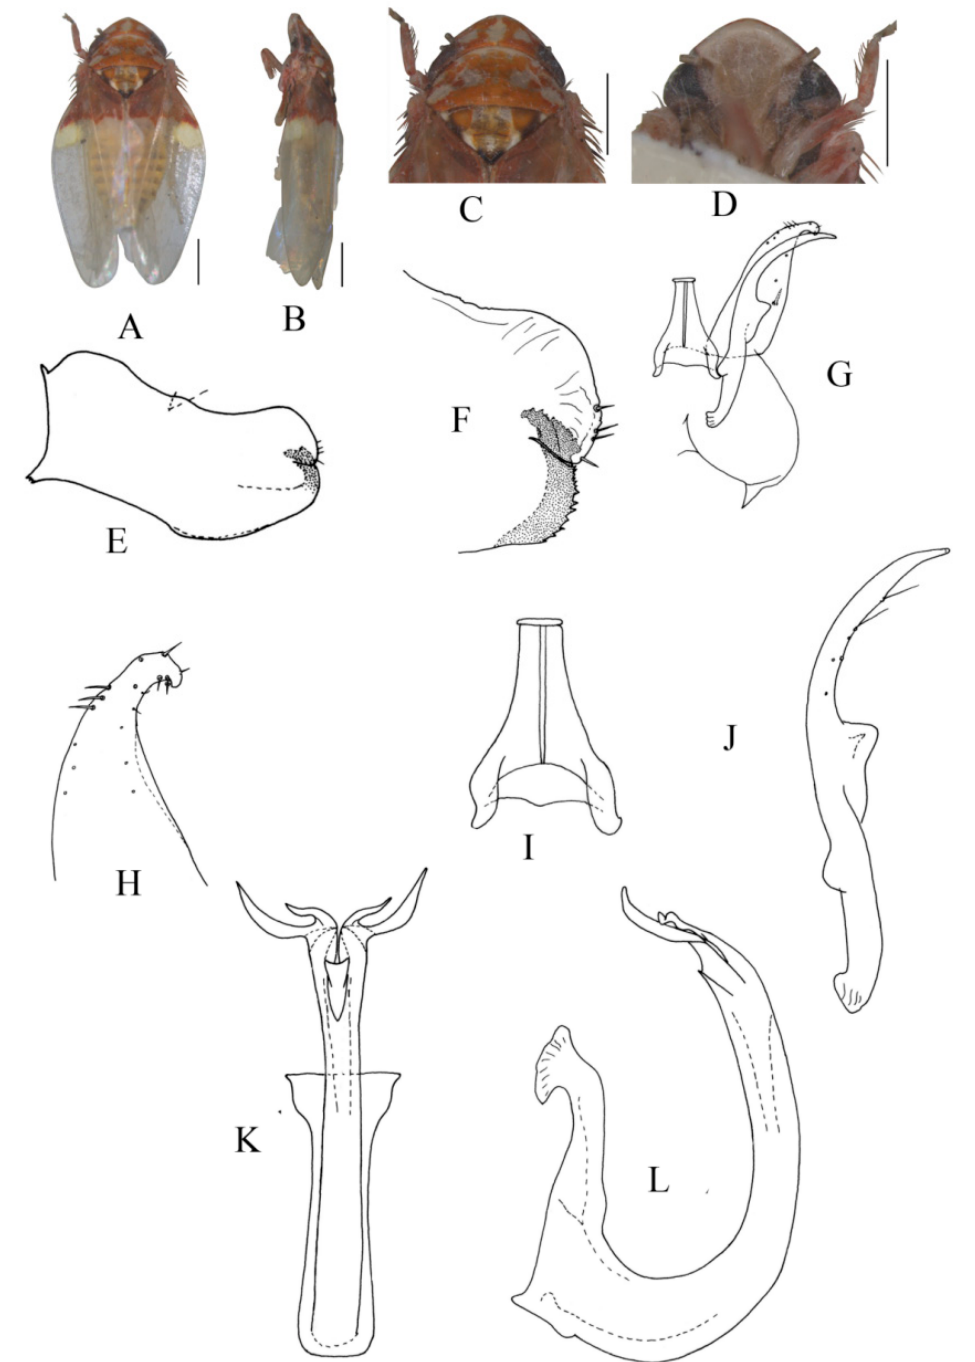
Figure 9. Eurhadina ( Singhardina ) amacularis sp. nov. : ( A ) habitus, dorsal view; ( B ) habitus, lateral view; ( C ) head and thorax, dorsal view; ( D ) face; ( E ) male pygofer side, lateral view; ( F ) hind part of pygofer, lateral view; ( G ) subgenital plate, connective, paramere and sternite IX, dorsal view; ( H ) apex of subgenital plate, dorsal view; ( I ) connective, dorsal view; ( J ) paramere, dorsal view; ( K ) aedeagus, posterior view; and ( L ) aedeagus, lateral view. Scale bars: 0.5 mm. Eurhadina ( Singhardina ) parilintanonica Zhang et Huang sp. nov. (Figure 10A–M) Body transparent, face sordid white. Crown creamy with four small orange patches anteriorly. Pronotum with orange fascia anteriorly and two blackish round patches pos- teriorly. Scutellum yellowish orange, basal triangles blackish. Forewing transparent with- out patch on basal half of corium; clavus with a blackish round patch centrally and bro- chosome area with a short traverse stripe on costal margin. Male genitalia : Upper lobe of pygofer side tuberculated distally, narrowed but with- out prominent short protrusion dorsally. Subgenital plate with long macroseta near basal 1/5, four short macrosetae near apical 1/3; two rigid microsetae on apex. Paramere slender and straight with three fine microsetae and four sensory pores on caudal part. Aedeagal shaft slim and curved, with two pairs of apical appendages; ventral appendages long and not branched, located between two branches of dorsal appendages; dorsal appendages